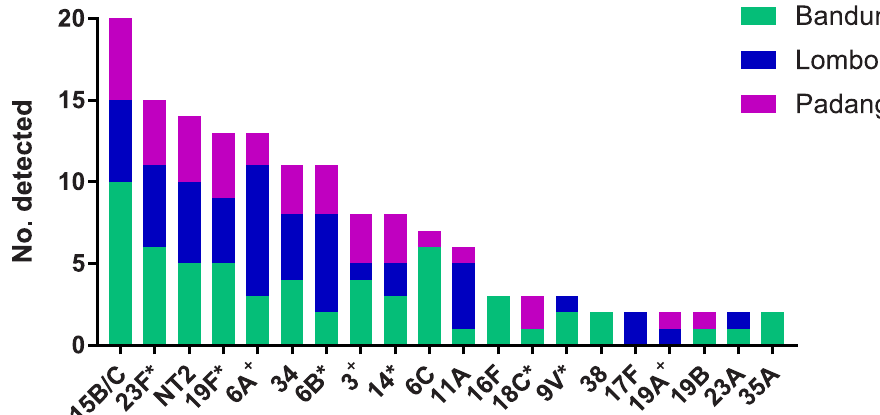
issues. There were four pneumococci for which serotype could not be determined: three were reported as 35A/10B-like by microarray (two of these were serogroup 33 by latex agglutina- tion/Quellung whilst the third did not undergo phenotypic typing), and the fourth was 39/6C- like by microarray and non-typeable by latex. Two of the six serotype 11A pneumococci iden- tified were typed as 11F-like by microarray, as previously described [26]. Multiple serotype car- riage was found in 18/296 (6.1%) of samples overall, and in 18/144 (12.5%) of pneumococcal- positive samples. Serotypes 15B/C, 23F, NT2, 19F, and 6A were the most commonly identified. Fig 2 depicts the 20 most common serotypes shown by region. Overall, 76/164 (46.3%) of pneumococci belonged to PCV13 serotypes, and 72/296 (24.3%) of participants carried a PCV13 serotype. For PCV10, these proportions were 53/164 (32.3%) and 52/296 (17.6%),